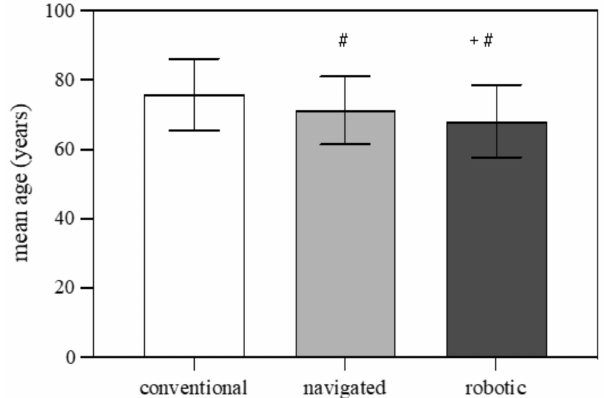
Figure 2. Bar chart for the mean age of the patients who were coded with three different types of TKA (conventional, navigated and robotic) performed in Germany between 2010 and 2021. Values are given as mean ± standard deviation. Two-way ANOVA; # p < 0.0001 vs. conventional; + p < 0.0001 vs.